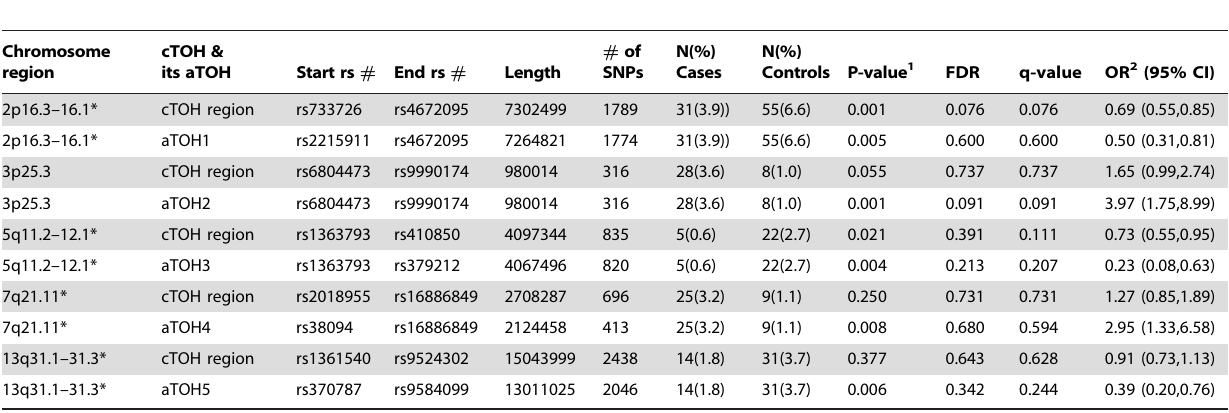
Table 2. Covariate-adjusted significant (p , 0.01) allelically-matched tracts of homozygosity (aTOHs) over- or under-represented in lung cancer cases compared to